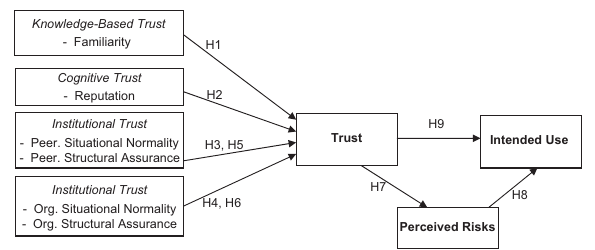
Figure 1. Research